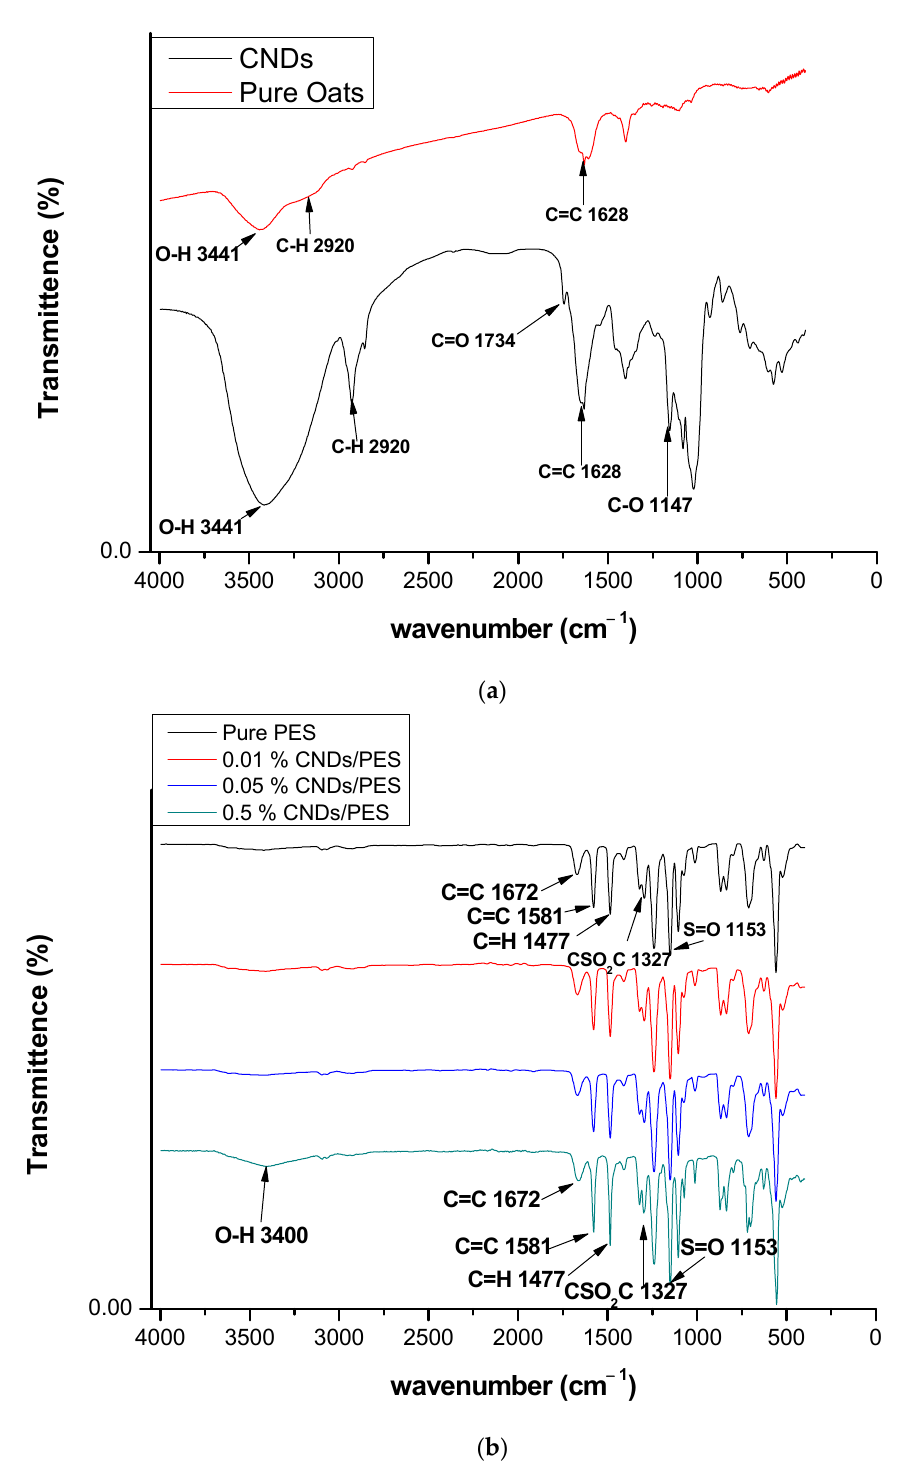
Figure 2. Characterization of the polyethersulfone (PES) and carbon nanodots coated on the polyethersulfone (CNDs/PES) using Fourier transform infrared spectroscopy (FTIR). ( a ) pure oats and CNDs; ( b ) PES and (CNDs/PES).